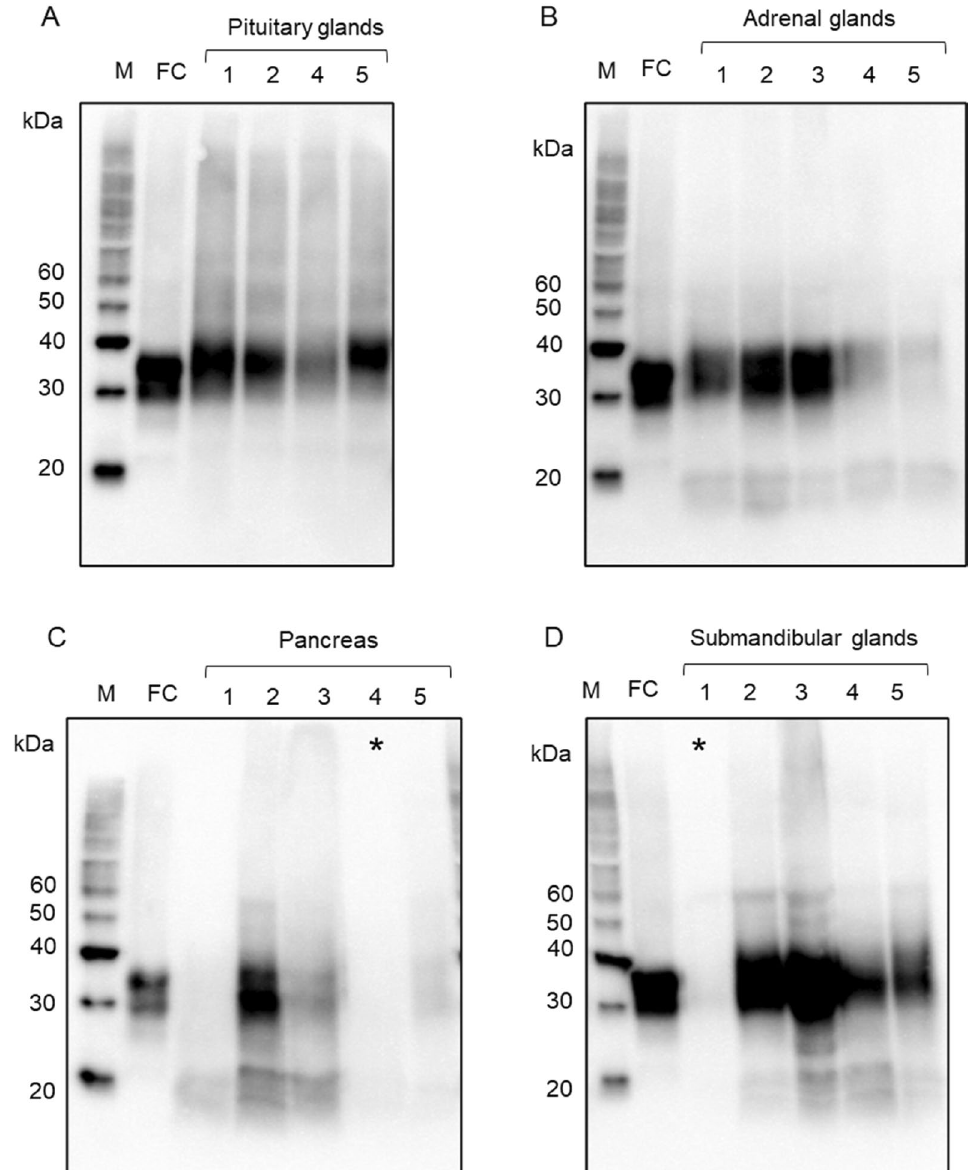
Figure 1. Western blot analyses from FFPE samples with the 3F4 anti-prion protein (PrP) antibody. ( A ) The frontal cortex (FC) samples show ~ 25–38 kDa PrP signals, and the pituitary gland samples (cases 1, 2, 4, and 5) show ~ 30–40 kDa PrP signals. ( B ) The adrenal gland samples (cases 1–5) show ~ 30–40 kDa and ~ 16–20 kDa PrP signals. ( C ) The pancreas samples (cases 1–5) show ~ 30–40 kDa and ~ 16–20 kDa PrP signals. The PrP signal is difficult to identify in case 4. ( D ) The submandibular glands (cases 1–5) show ~ 30–40 kDa and ~ 16–20 kDa PrP signals. The PrP signal is difficult to identify in case